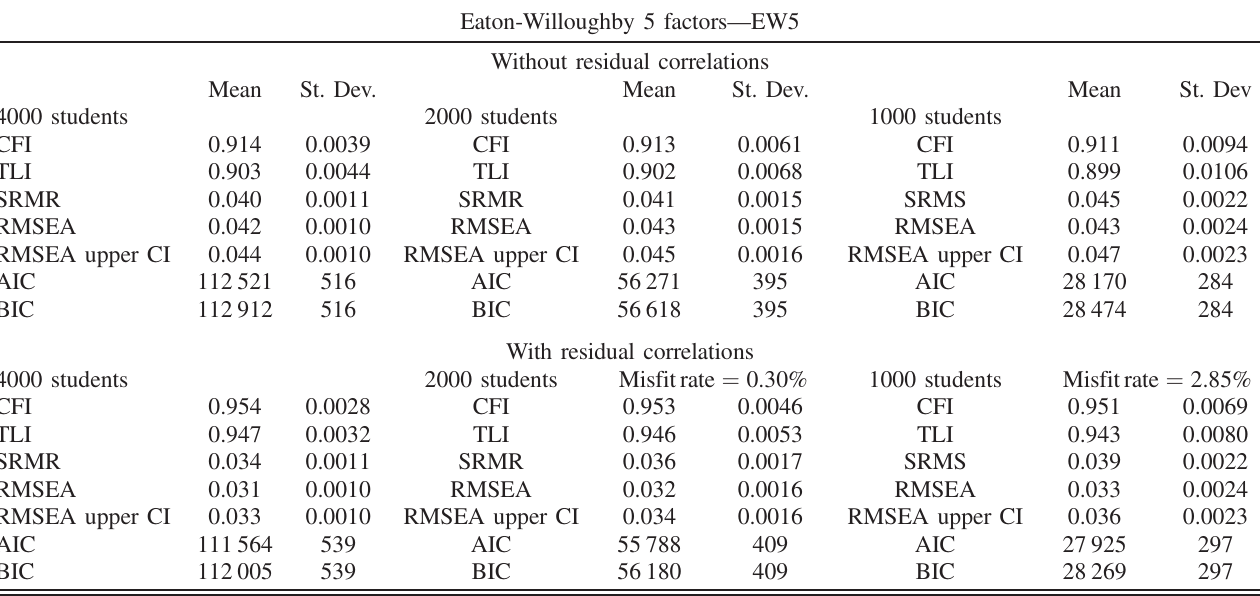
TABLE VII. Fit statistics ’ mean and standard deviations of 2000 samples of size 4000, 2000, and 1000 students for the EW5 model. Some of the smaller samples tested misfit with the model, but the rate of misfits was never above 3% for the model with correlations in place. This suggests that for samples smaller than 1000 students the model without correlation should be fitted to the data first and then correlation can be added after model-data fit has been established. As the sample sizes get smaller the fit statics get worse, but never get to the point of representing a poor model